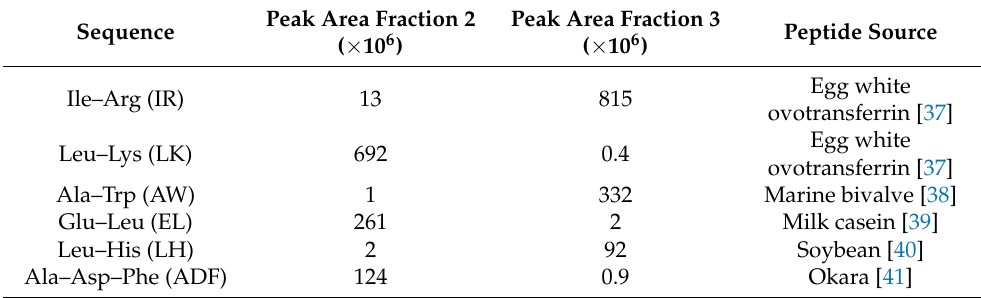
Table 1. Short peptides matching with BIOPEP-UWM sequences validated for antioxidative activity. Peak areas are average values of all the